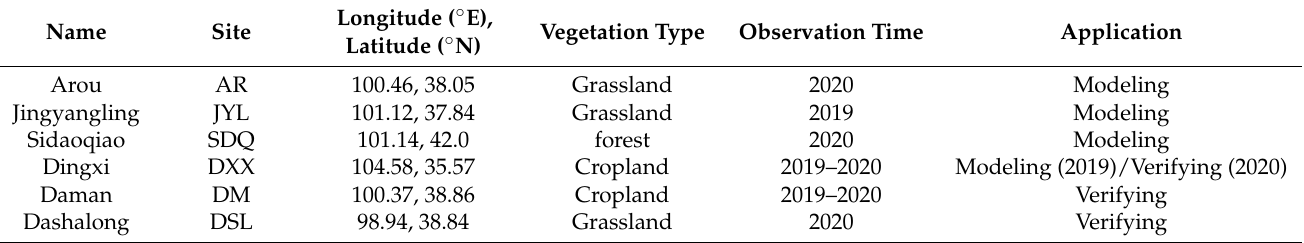
Table 2. Overview of the observation sites used for ET regulation.